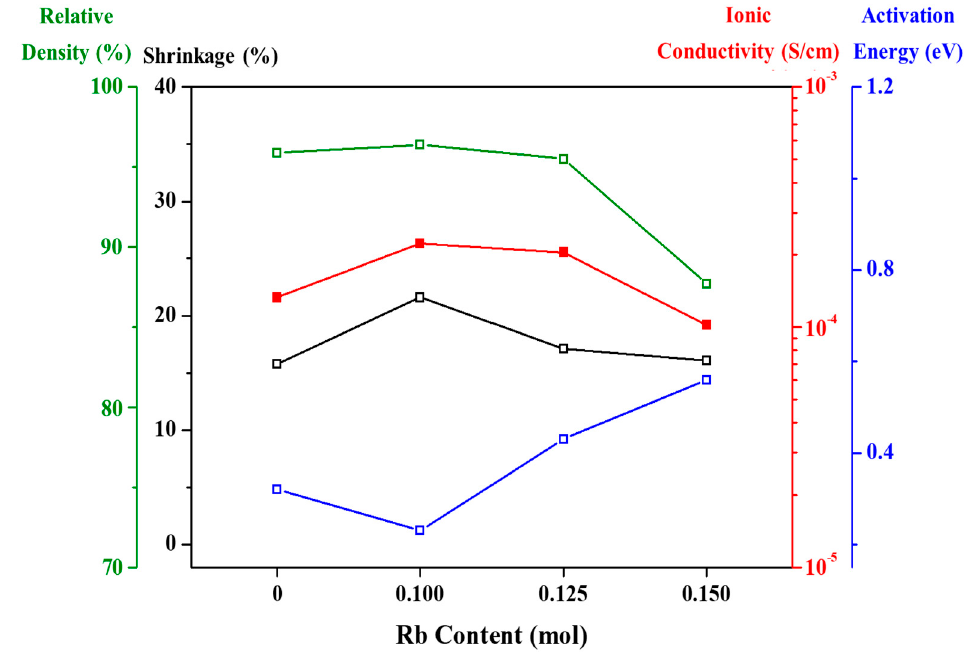
Figure 9. Changes in physical properties including Li-ion conductivity of tri-doped LLZO ceramics according to Rb content.